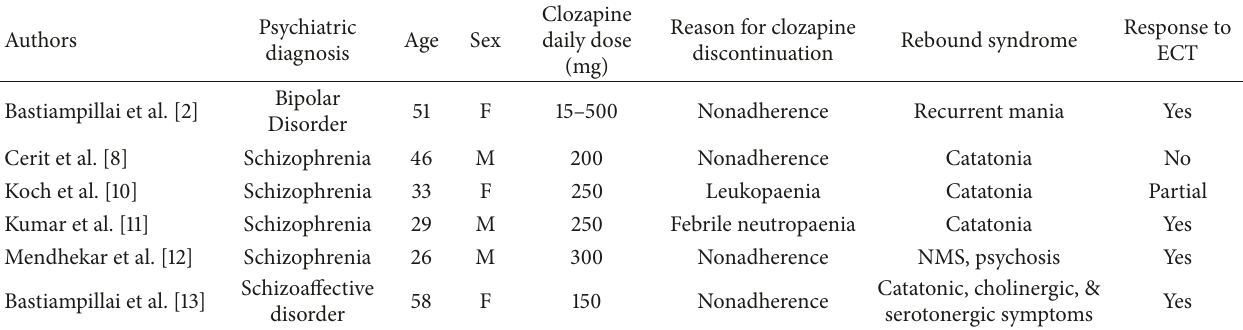
Table 1: Published case reports of syndromes precipitated by clozapine withdrawal treated with electroconvulsive therapy.